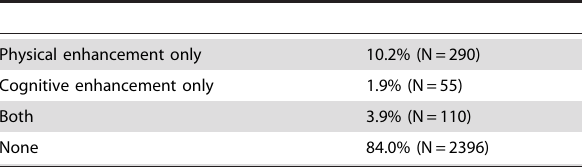
Table 6. 12-month prevalences for the use of legal and freely available